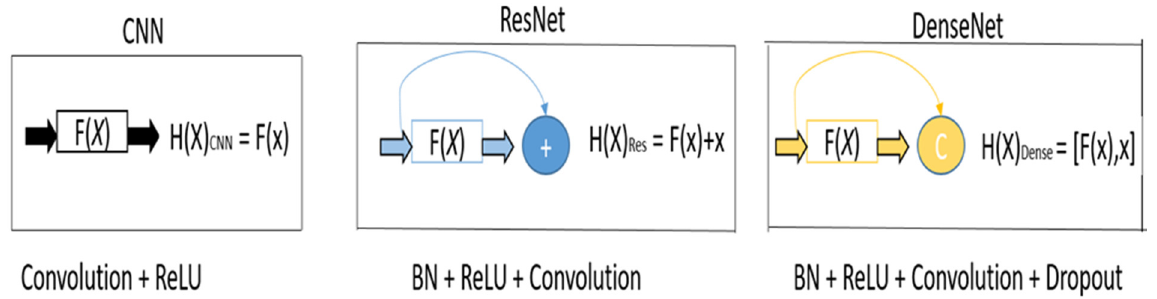
Figure 1. Basic design of CNN, ResNet, and DenseNet.